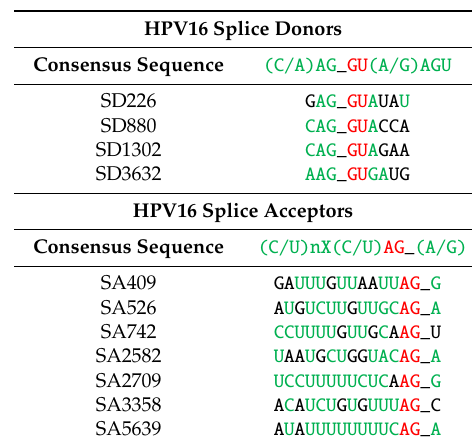
Table 1. Sequence of consensus and HPV16 splice donors and